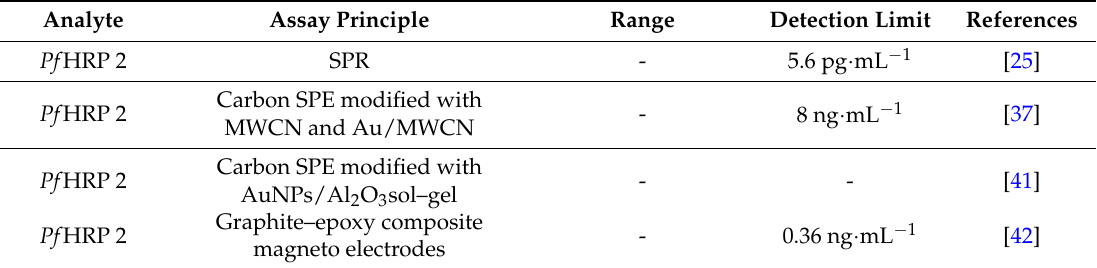
Table 1. Different biosensor technology for detecting P fHRP 2, and their detection limits. Analyte